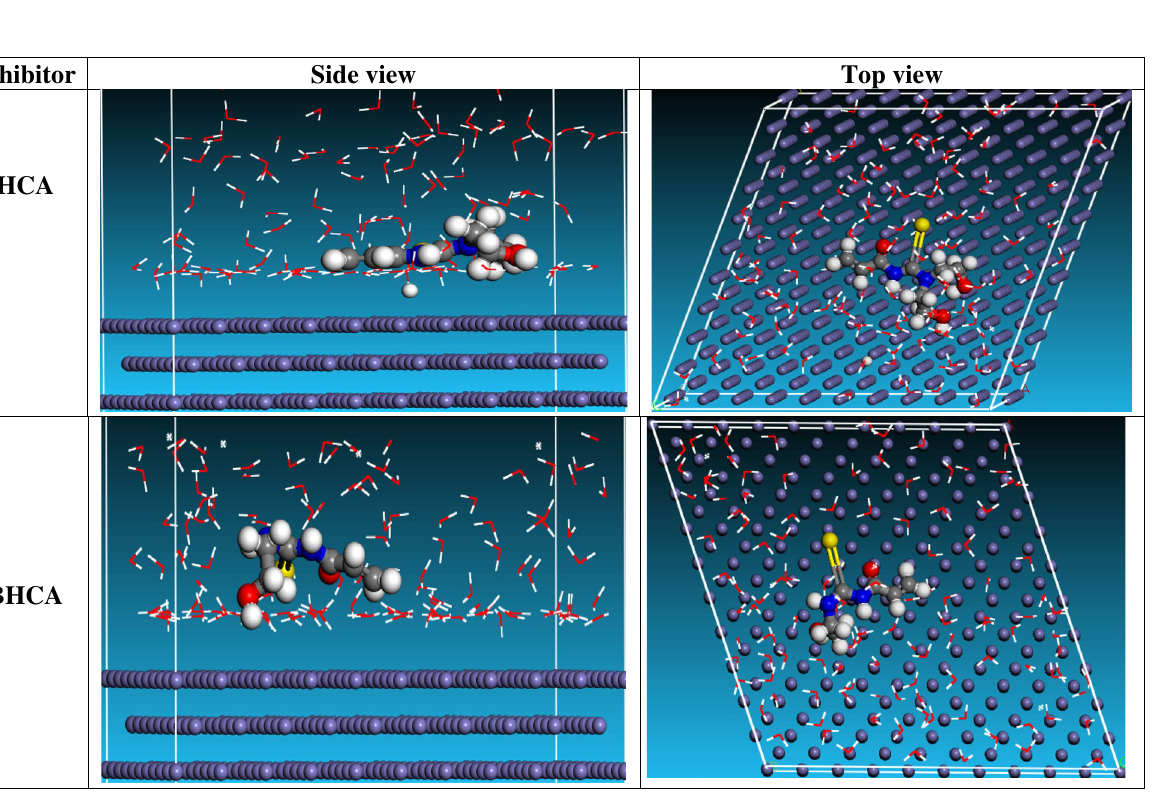
Figure 13. The inhibitors’ equilibrium adsorption configurations on the surface of Fe (110): top and side